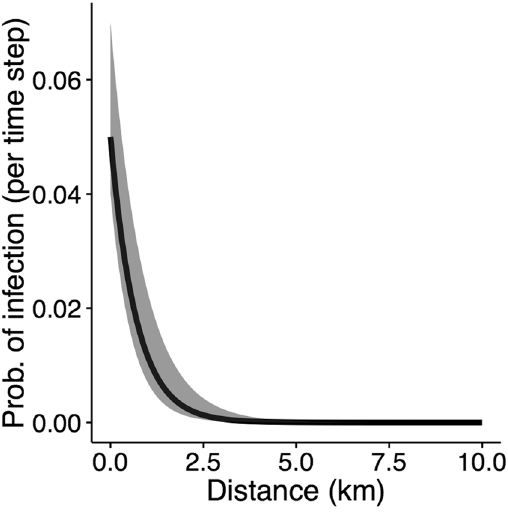
Figure 2. Fitted spatial transmission kernel describing the probability of transmission between two farms by distance when the prevalence in the infected farm is 1. The gray area represents uncertainty in the parameter estimates (Table